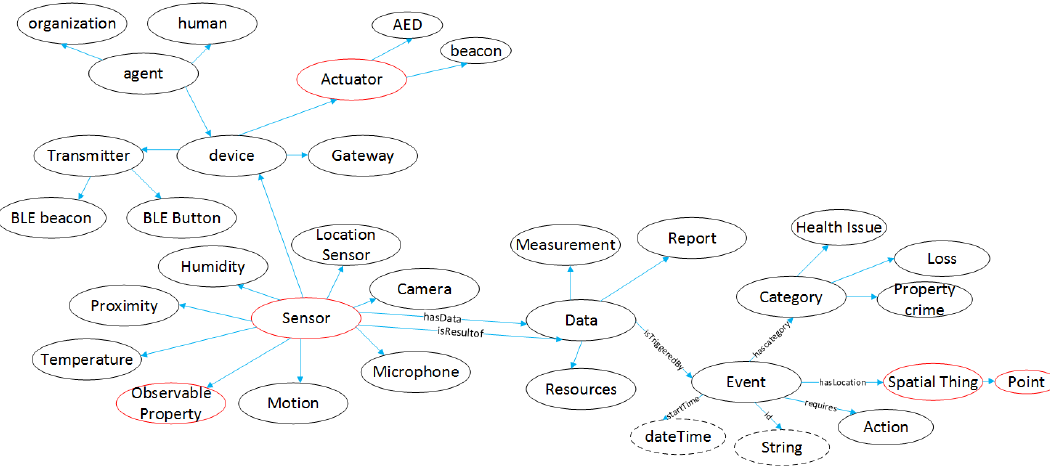
Figure 8. Entities in Desmos ontology.